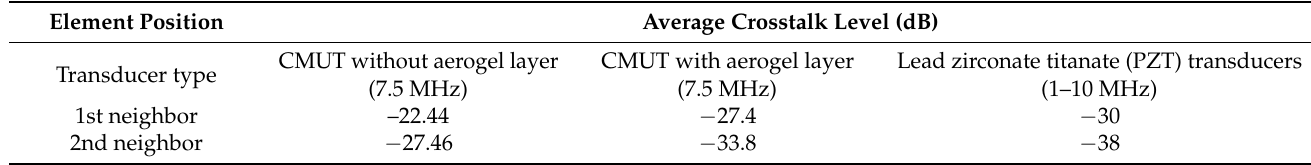
Table 7. Comparison of crosstalk levels of CMUTs with an aerogel coating and piezoelectric transducers [21]. Element